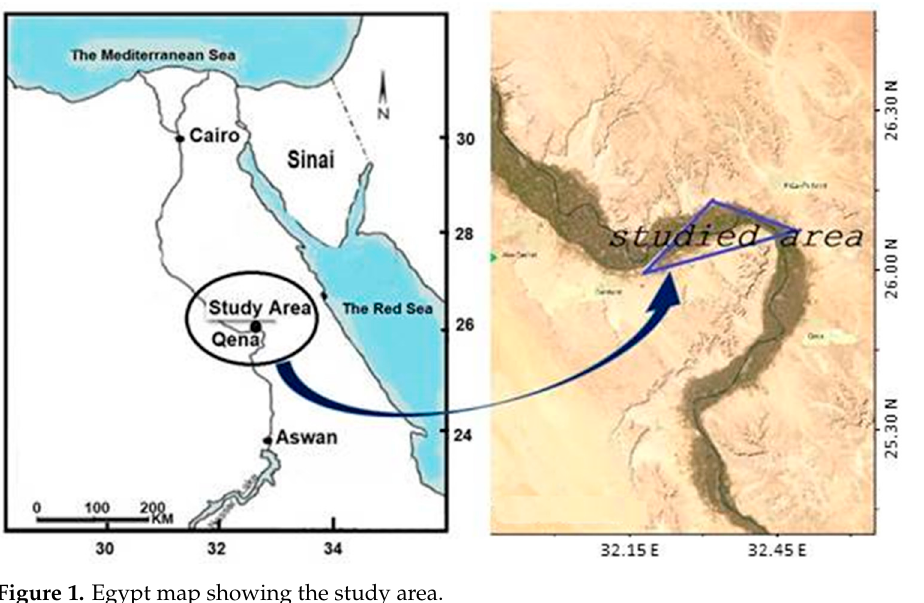
Figure 1. Egypt map showing the study area.